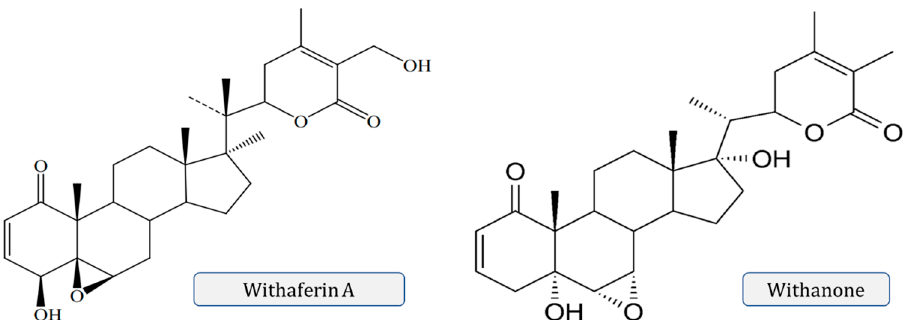
Figure 5. Chemical structure of withaferin A and withanone.